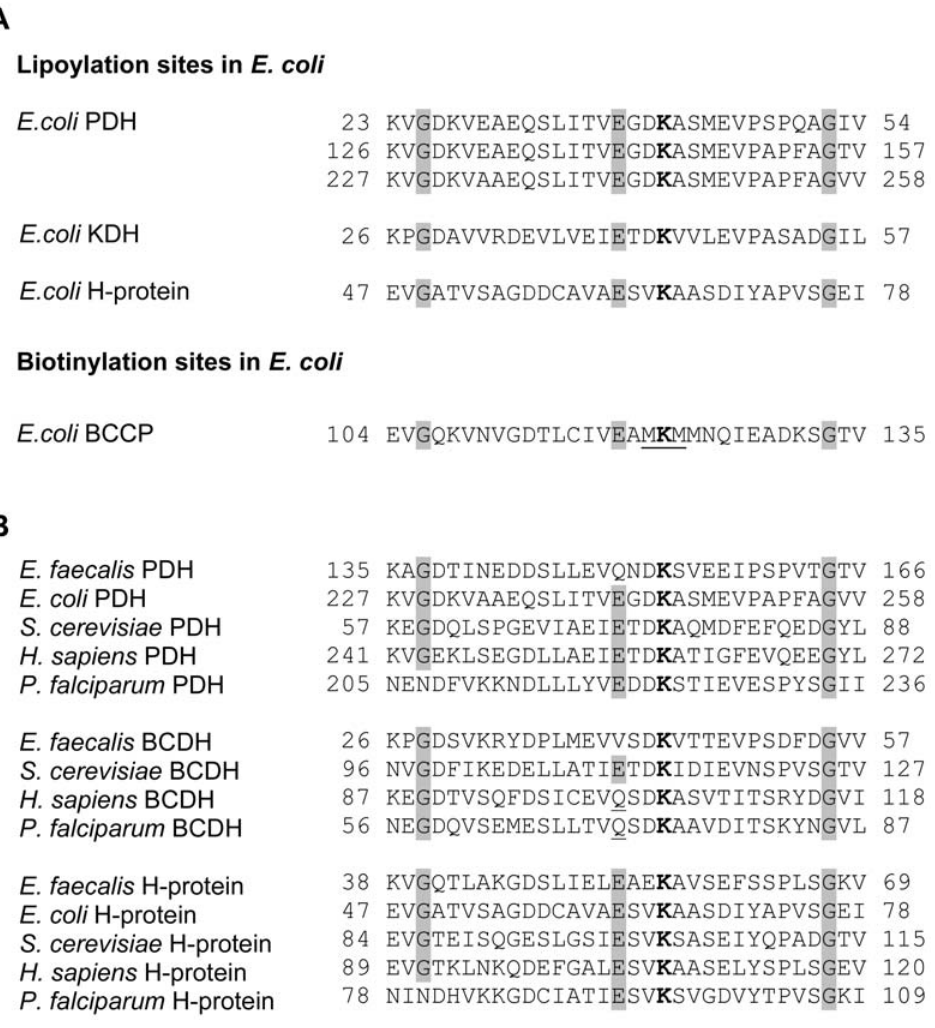
Figure 7. Lipoylation and biotinylation sites. ( A ) Amino acid sequence alignments of lipoylation and biotinylation sites in E. coli . The lysine that is involved in lipoic acid or biotin attachment is marked in bold. Residues corresponding to conserved glycine and glutamine residues are shaded [33]. Residues forming the biotinylation consensus site are underlined. ( B ) ClustalW comparison of amino acid sequences surrounding the site of lipoate attachment for lipoylated proteins found in E. faecalis . The substitution of the Glu three residues amino-terminal to the lipoyl lysine with Gln (underlined residues) is a common motif in the BCDH E2.